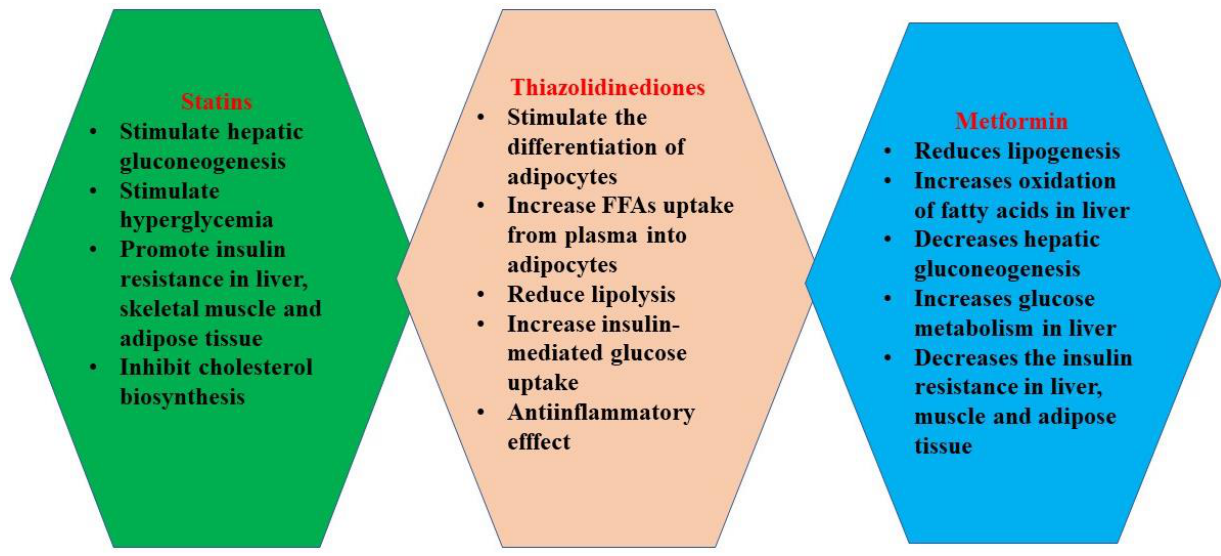
Figure 4. Effects of statins, thiazolidinediones, and metformin.